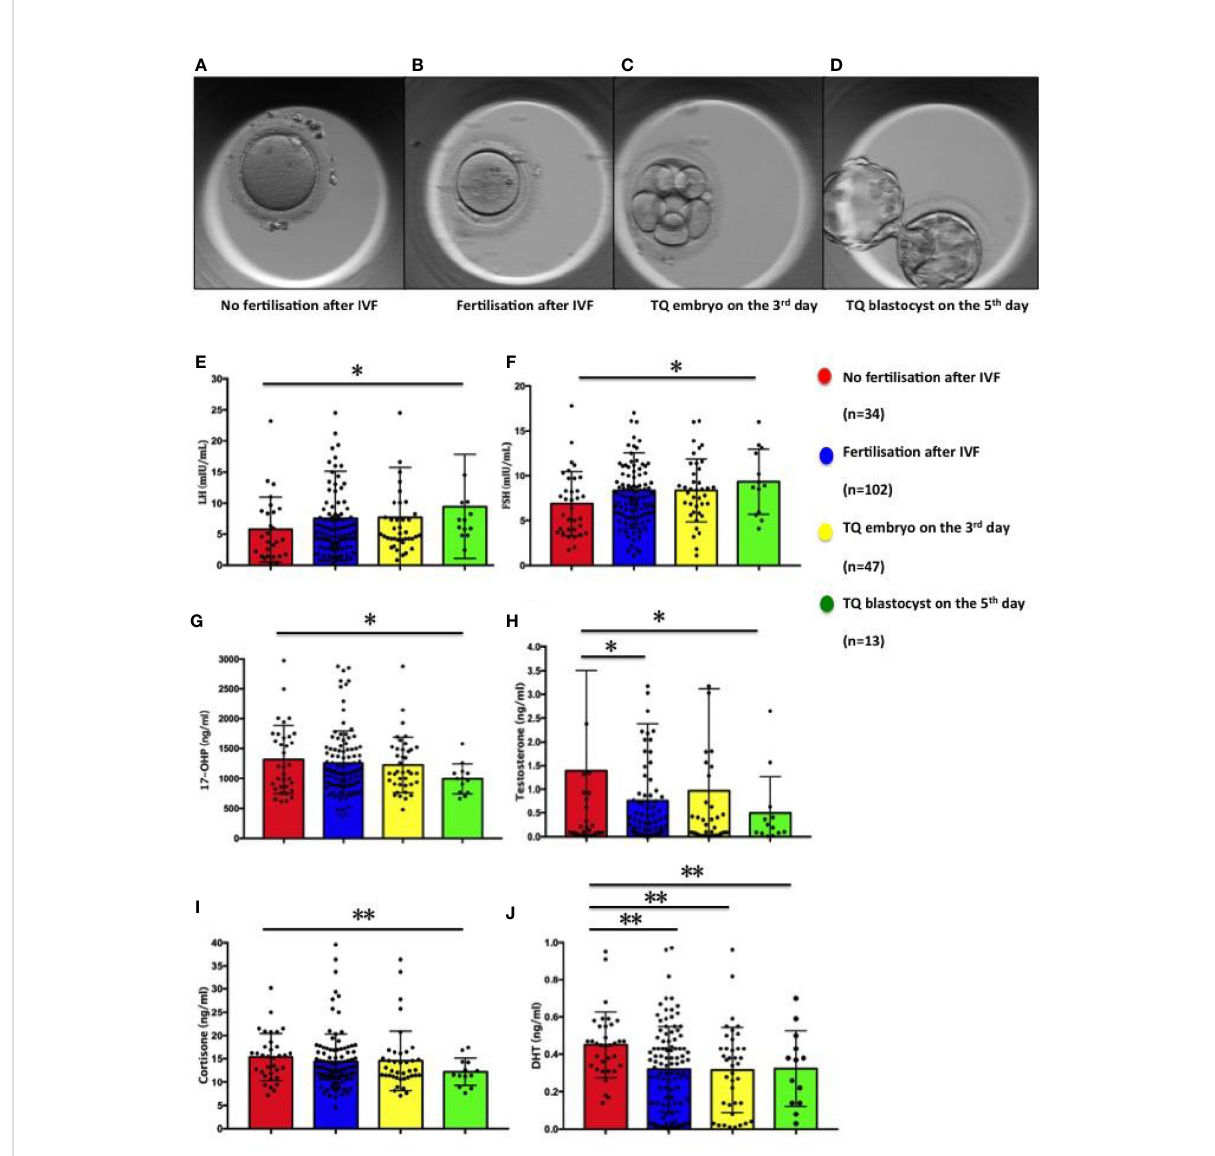
FIGURE 2 Figures of oocyte and embryo in different developmental states and distribution of steroid and gonadotropic hormone concentrations in follicular fl uid in relation to the corresponding oocytes: fertilisation and subsequent embryo development. (A) Oocyte of no fertilisation after IVF; (B) Embryo fertilisation after IVF; (C) TQ embryo on the 3 rd day; (D) TQ blastocyst on the 5 th day; (E) LH; (F) FSH; (G) 17-hydroxy pregnenolone (17-OHP); (H) Testosterone; (I) Cortisone; (J) Dihydrotestosterone. Comparison between groups was performed using Kruskal- Wallis one-way ANOVA. *p< 0.05, **p<